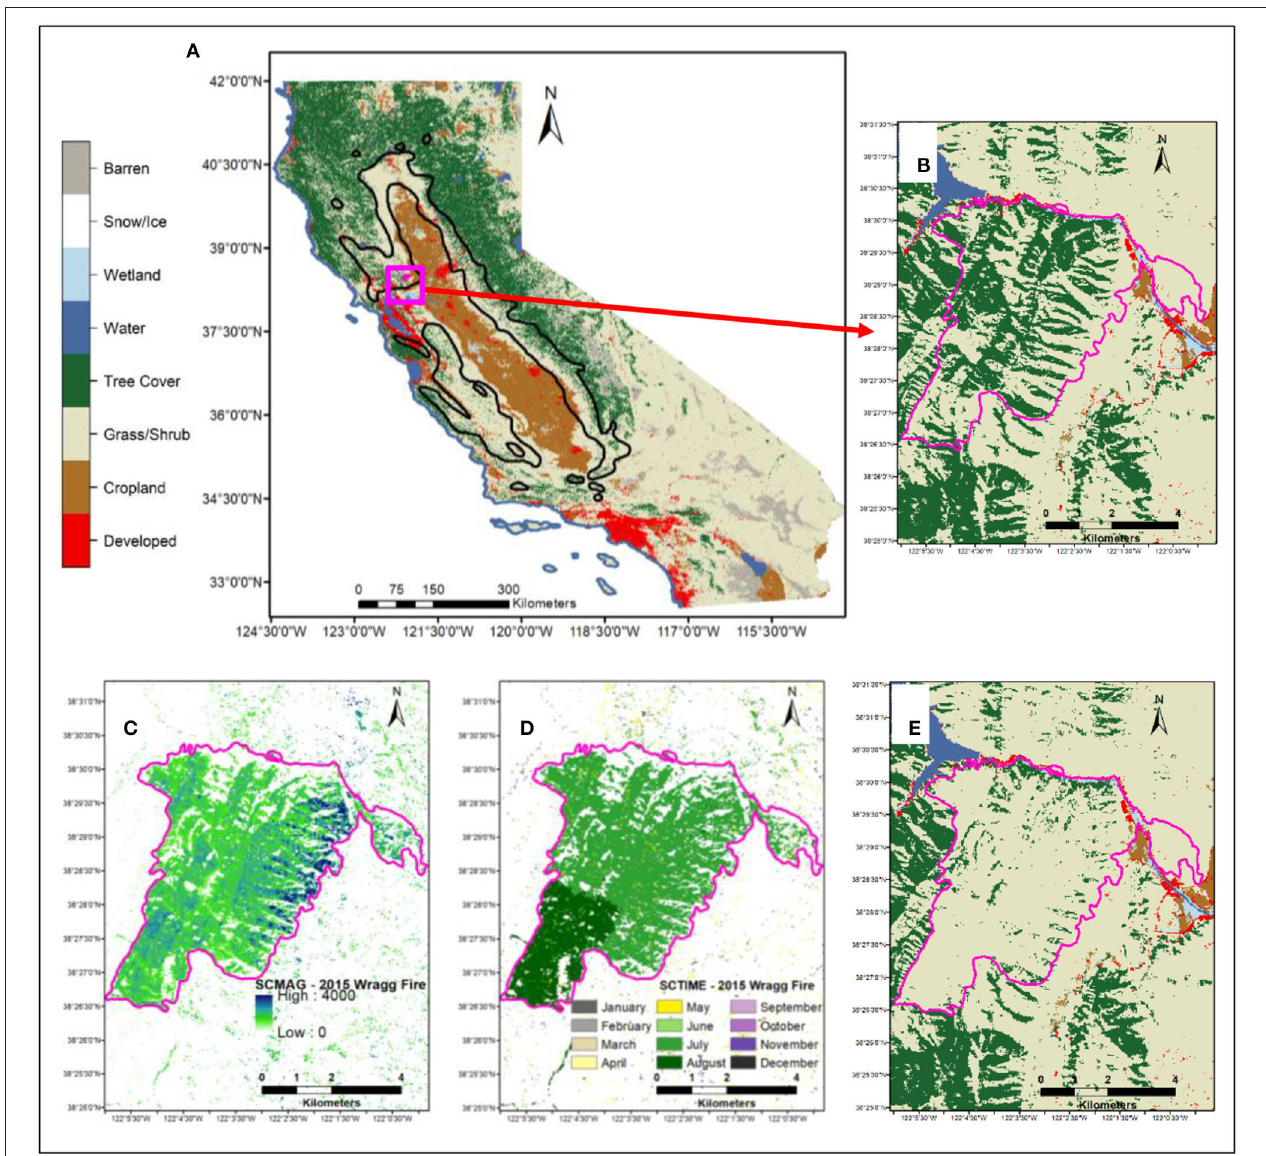
FIGURE 1 | Map of study area showing: (A) LCMAP Primary Land Cover (LCPRI,) of 1985 of California indicating location of blue oak species range (black boundary); (B) LCPRI of 2014 (pre-fire land cover) zoomed to location of the Wragg fire of 2015 (pink polygon, from MTBS fire perimeter database); (C) LCMAP Change Magnitude (SCMAG) indicating spectral change and the degree of change associated with the Wragg fire of 2015; (D) LCMAP Time of Spectral Change (SCTIME) indicating timing of spectral change (day of year) of CCDC model breaks following the Wragg fire in 2015; (E) LCPRI of 2016 (post-fire land cover) indicating tree cover loss to grass/shrub following the Wragg fire of 2015 (pink polygon, from MTBS fire perimeter database).